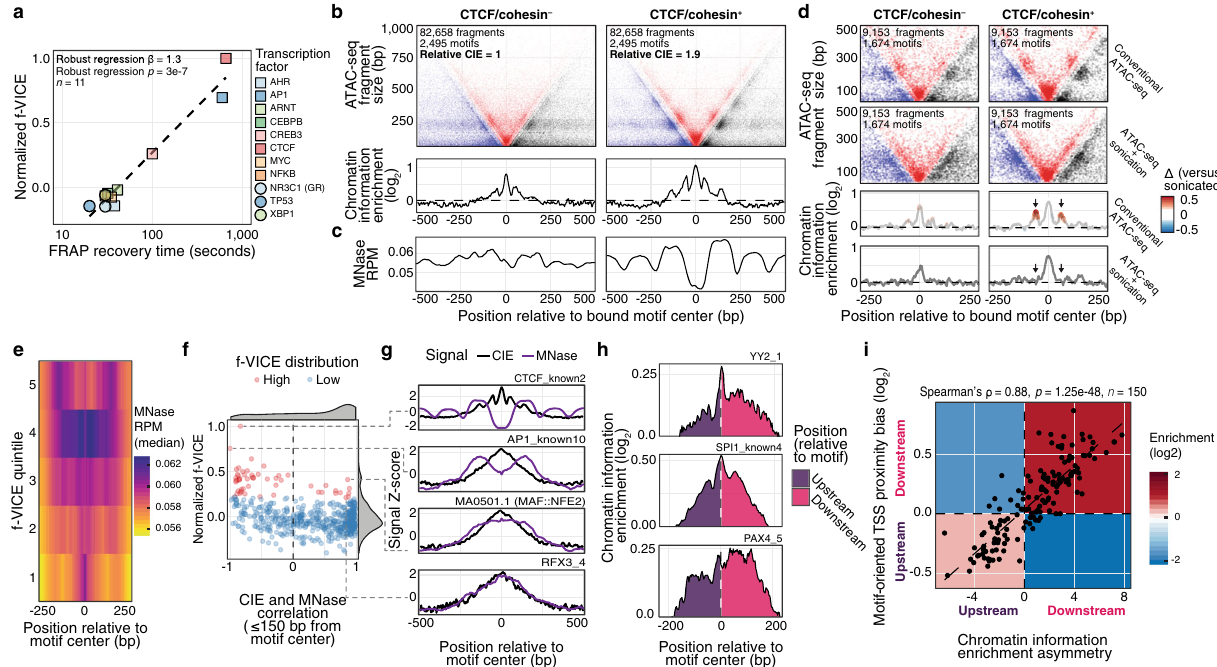
Fig. 2 Chromatin information informs residence times and TF-nucleosome interactions. a Correlation of FRAP recovery times and GM12878 f-VICEs. Dashed line, linear model fi t. b V-plots and CIEs of CTCF/cohesin + and CTCF/cohesin − motifs. c , GM19238 MNase-seq reads per million mapped reads at the same motifs. d CTCF/cohesin + and CTCF/cohesin − motifs in the sonicated and conventional GM12878 ATAC-seq data. Colors, differences relative to sonicated. e Median nucleosome occupancy across motifs from different f-VICE quintiles in the GM12878 ATAC-seq data generated in this study. f Scatter plot of CIE and MNase correlation ≤ 150 bp from the motif as function of f-VICE. g High f-VICE motifs associated with nucleosome phasing (top) or a well- positioned nucleosome at the motif region (bottom). h Top 3 motifs with CIE asymmetry Z-scores in GM12878. i Scatter plot of motif-oriented TSS position bias and CIE asymmetry in TSS-proximal motifs. Enrichments calculated by permuting the signs of observed values ( n = CIE of the GM12878 lymphoblastoid cell line CTCF binding sites positions obtained both from ATAC-seq using the NucleoATAC with and without the presence of cohesin (CTCF/cohesin + algorithm 26 and from lymphoblastoid MNase-seq pro fi les (Sup- plementary Fig. 20). High f-VICE motifs had lower nucleosome